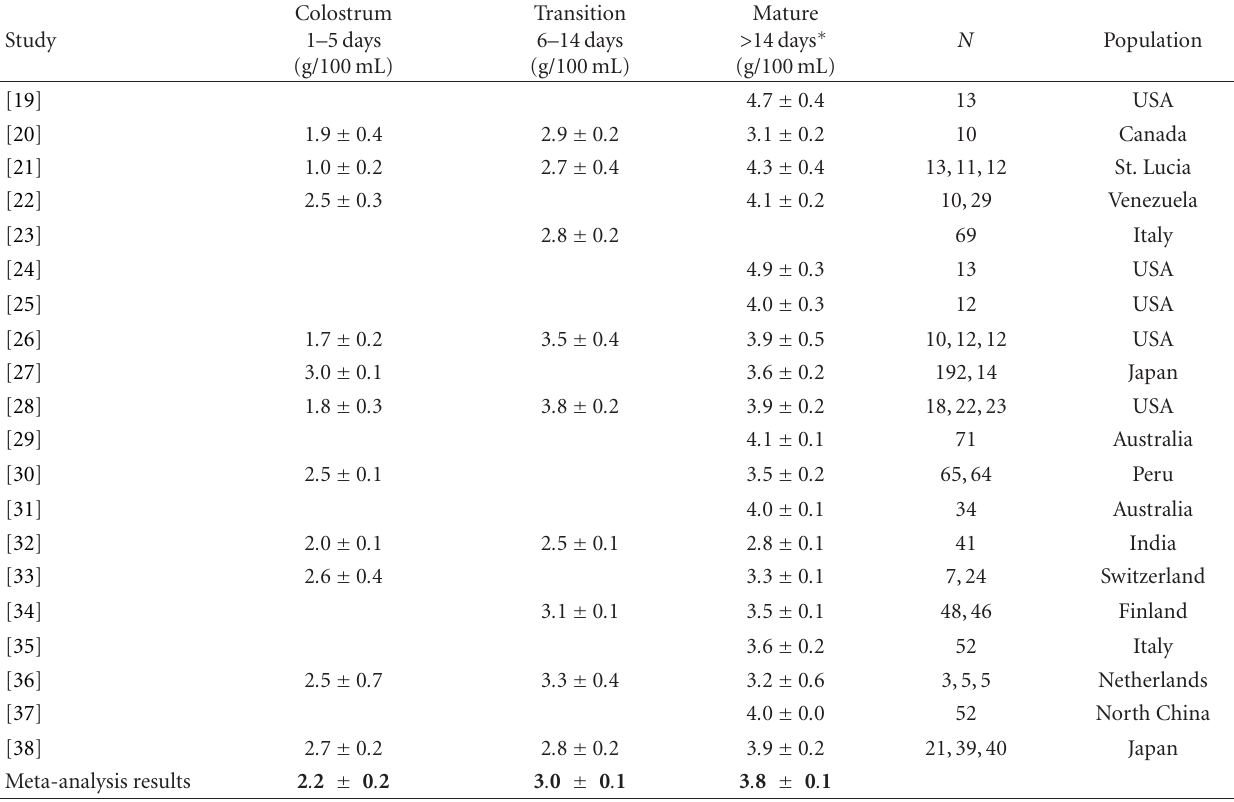
Table 2: Lipid concentration in breast milk (g/100